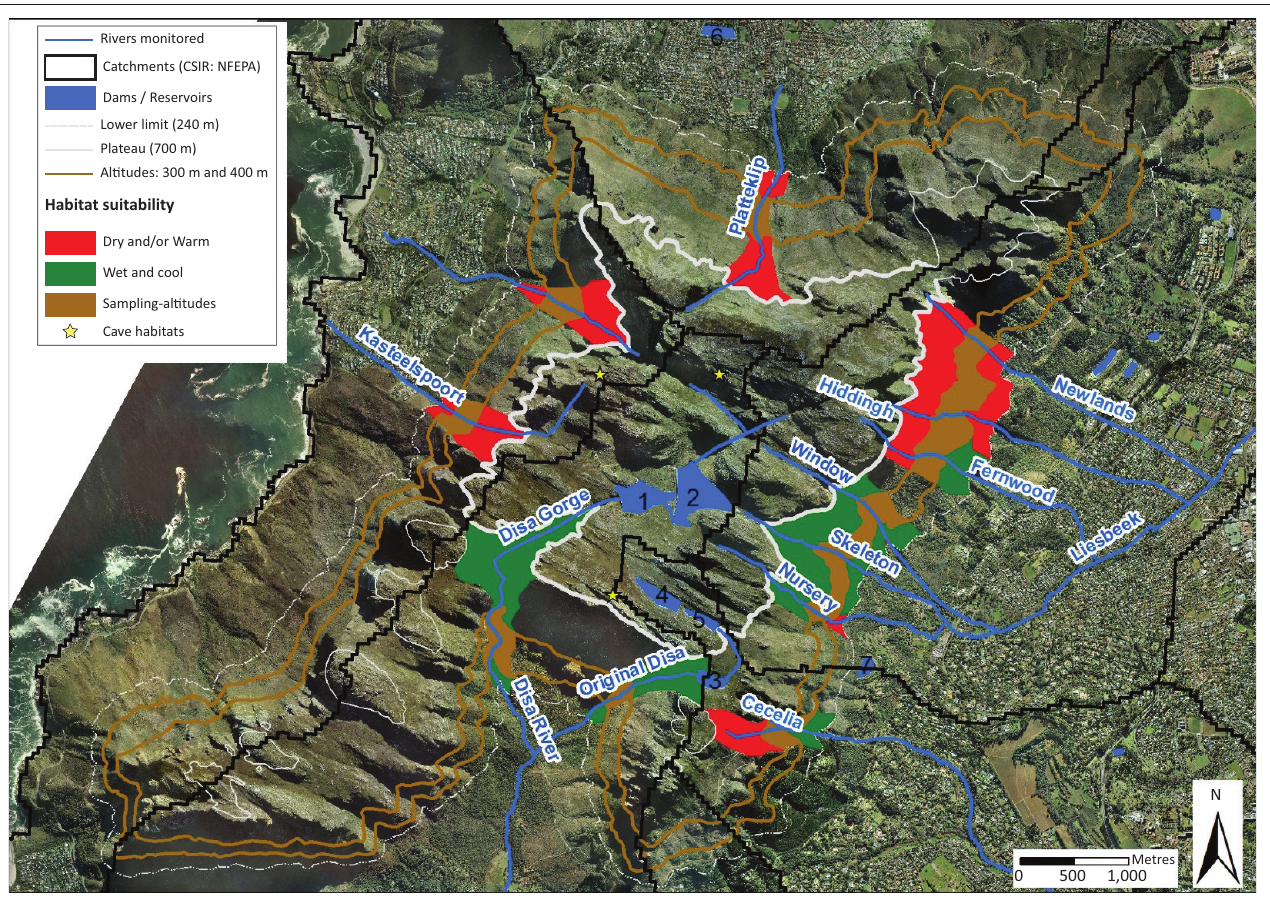
FIGURE 1: Findings of this study are extrapolated for each stream between the lower limit of the species and the massif’s plateau. Water temperature and water flow